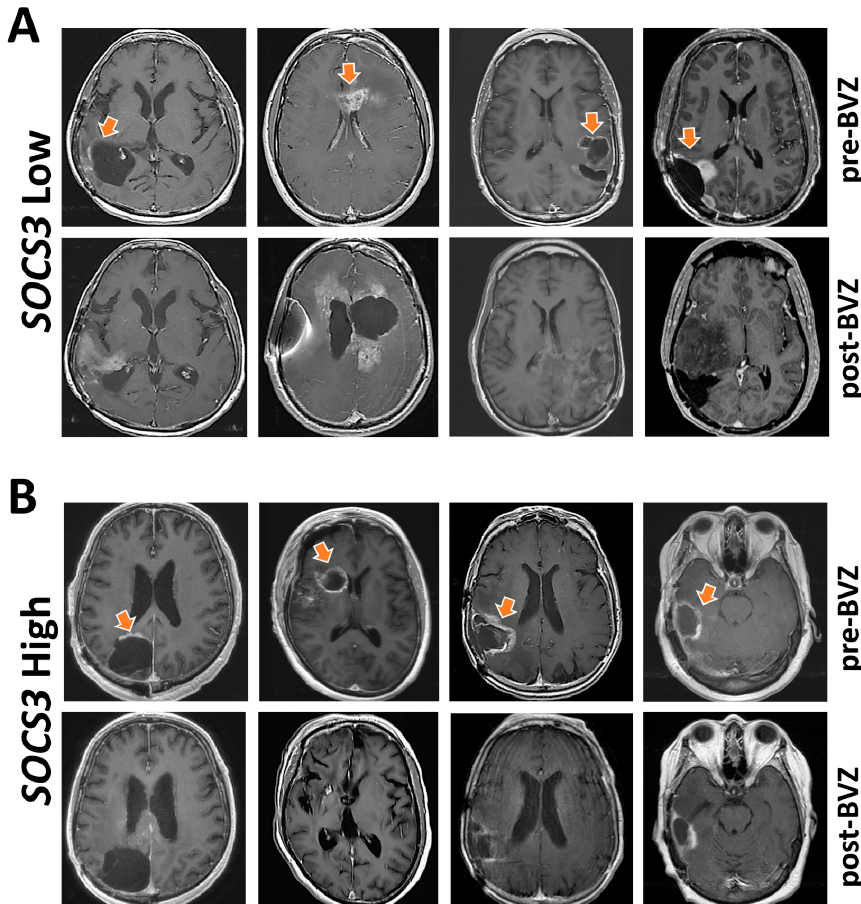
Figure 6. SOCS3 expression levels and angiogenesis inhibition. Eight patients were selected from the Ivy Glioblastoma Atlas Project (Ivy-GAP) dataset. ( A ) Four patients who had average SOCS3 expression Z-scores > 0 were considered as a SOCS3 High expression group. ( B ) Another group of four patients with SOCS3 expression Z-scores < 0 were identified as a SOCS3 Low expression group. T1 post-Gad MRI images were studied before and after BVZ treatment. Each patient received at least two doses of BVZ. Orange arrows indicate radiological features related to GBM progression that decreased post-BVZ treatment in the SOCS3 High expression group.